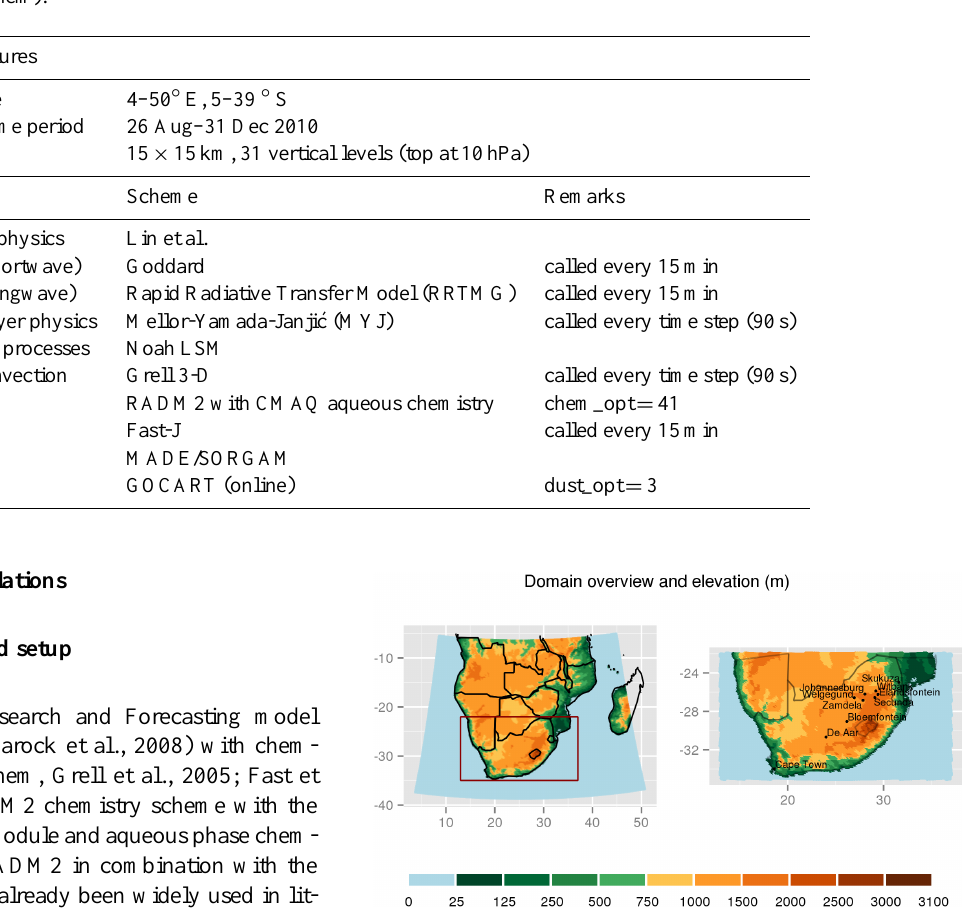
Table 1. General features of the setup, physics and chemistry schemes used in the configuration of the Weather Research and Forecasting model with chemistry (WRF-Chem).